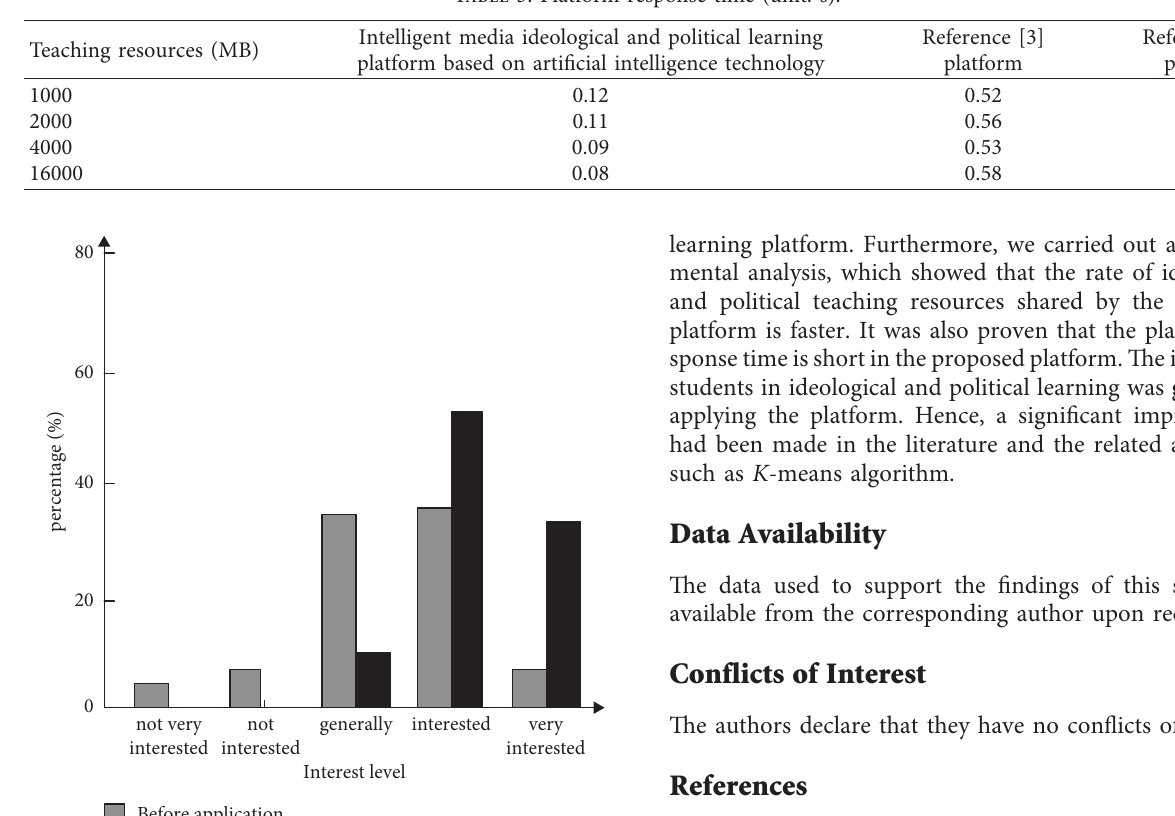
Table 3: Platform response time (unit: s).